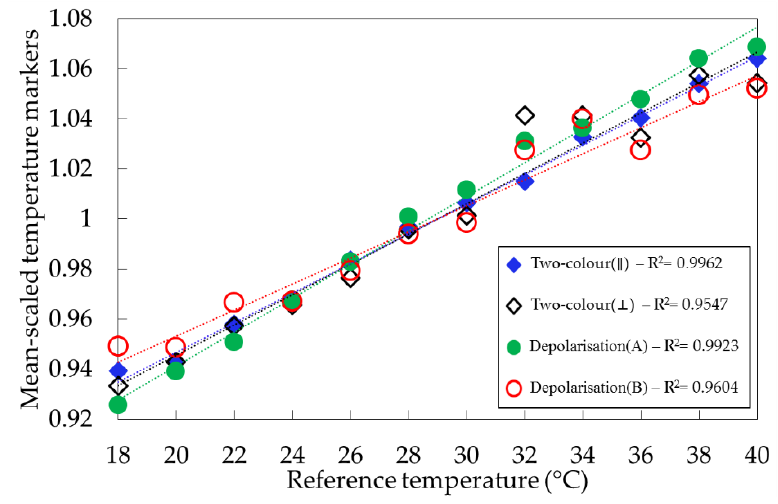
Figure 5. Mean-scaled temperature markers for Milli-Q water.